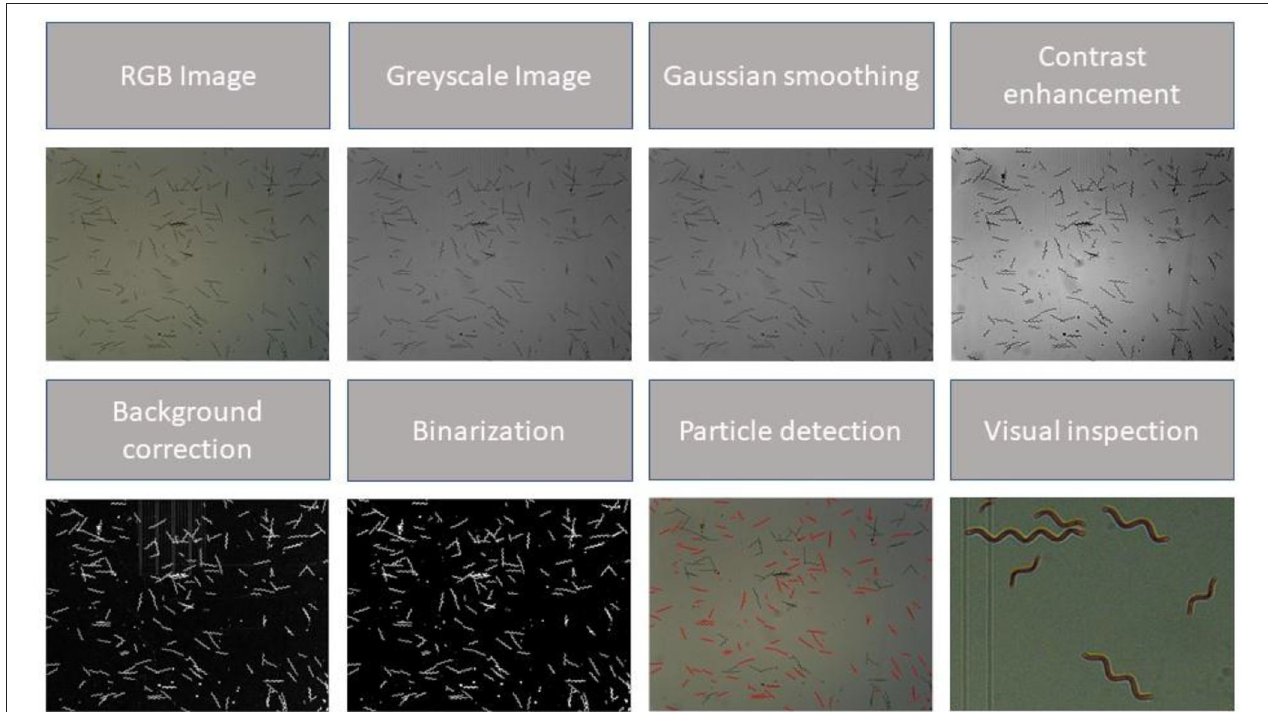
FIGURE 1 | Concept of the proposed image processing algorithm. From top left to bottom right: The (RGB) image was loaded and converted into a grayscale image. The image was smoothed by applying a Gaussian filter, and the contrast was enhanced. The background was subtracted, and the picture was binarized. Particle detection was performed by filtering the detected particles based on their region properties. Edge detection and particle detection were inspected visually, and parameters were adapted if the result was inconvenient. Note that border clearing and filling of smaller holes are not presented in this